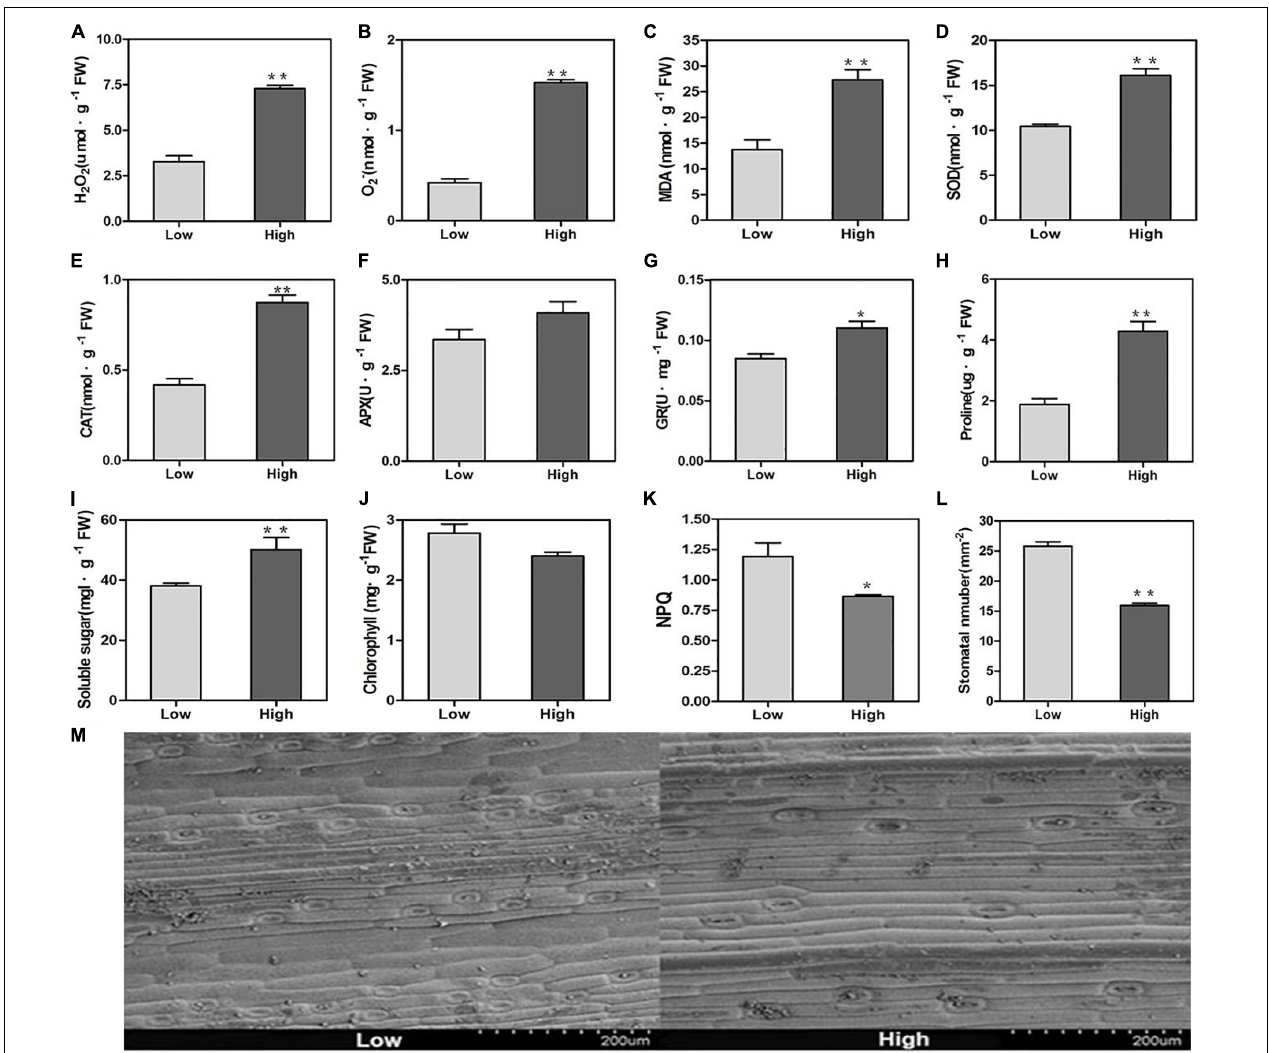
FIGURE 1 | Physiological changes of oats at low and high altitudes. (A) H 2 O 2 activity, (B) O 2 − activity, (C) MDA activity, (D) SOD activity, (E) CAT activity, (F) APX activity, (G) GR activity, (H) proline content, (I) soluble sugars content, (J) chlorophyll content, (K) NPQ, (L) stomata density. Values represented the means ( ± SE) from three fully independent biological replicates. Significant differences from the low altitude were denoted by one or two asterisks corresponding to P < 0.05 and P < 0.01, respectively, by the Student’s t -test. (M) The photographs of stomata of oats at low and high altitudes.